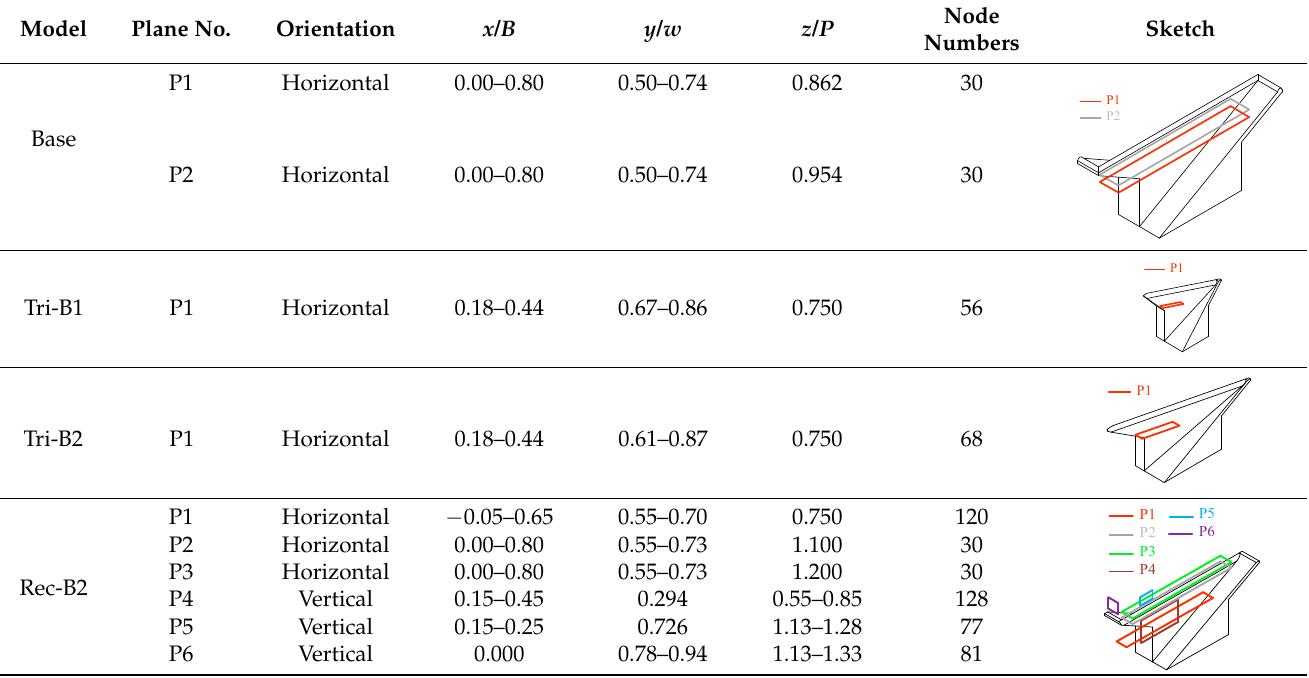
Figure 10, the high diffusion of the injected dye confirms the presence of the separation zone in the downstream section of a rectangular PKW. It may diminish at the smaller A / w values, where the sidewalls act as a nose to guide the inflow. In addition, the recirculation vortices may appear as some undulations on the water surface (not observed for smaller A / w and H o / P values). Table 2. Specifications of velocity measurement planes